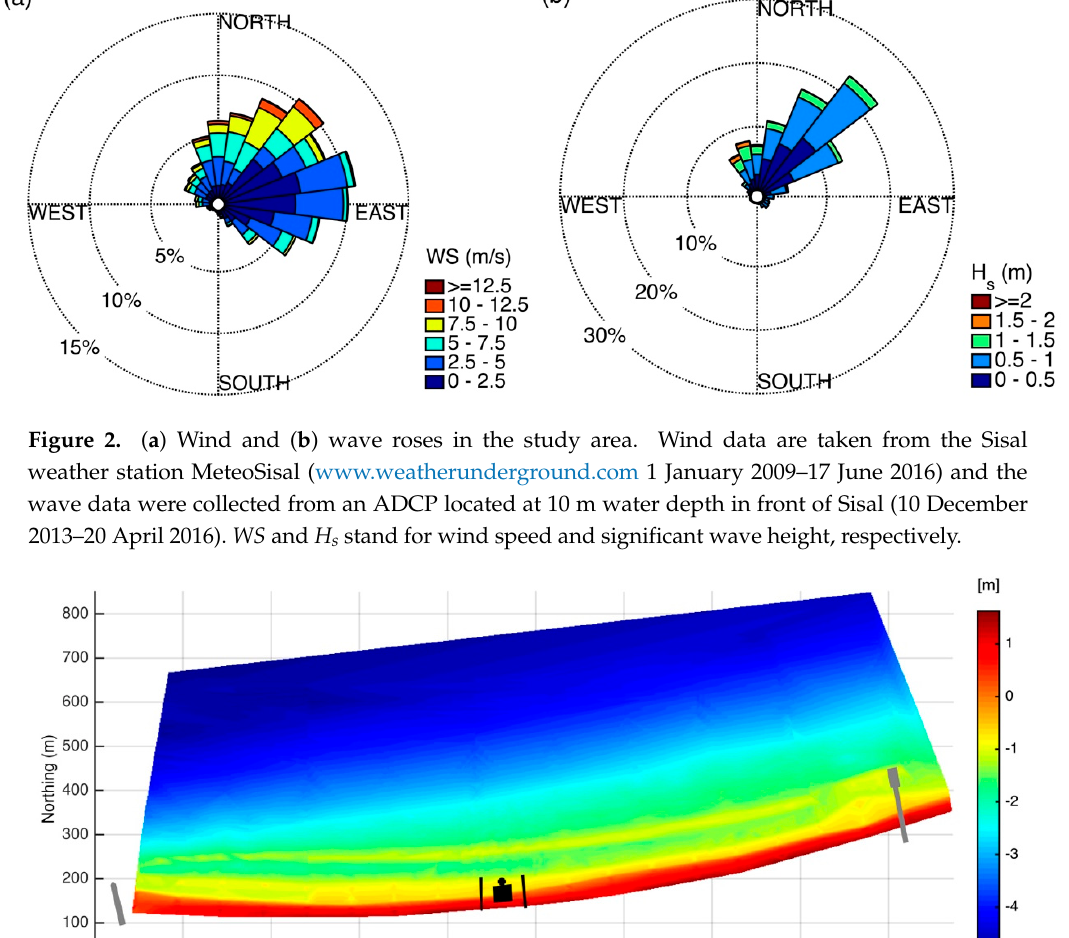
Figure 2. ( a ) Wind and ( b ) wave roses in the study area. Wind data are taken from the Sisal weather station MeteoSisal (www.weather underground.com 1 January 2009–17 June 2016) and the wave data